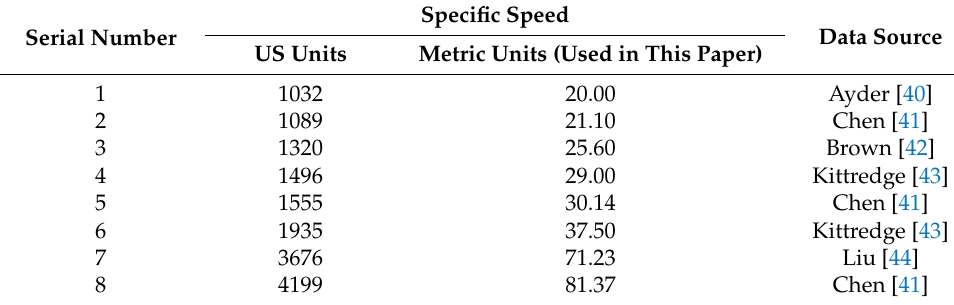
Table 1. Eight centrifugal pumps with different specific